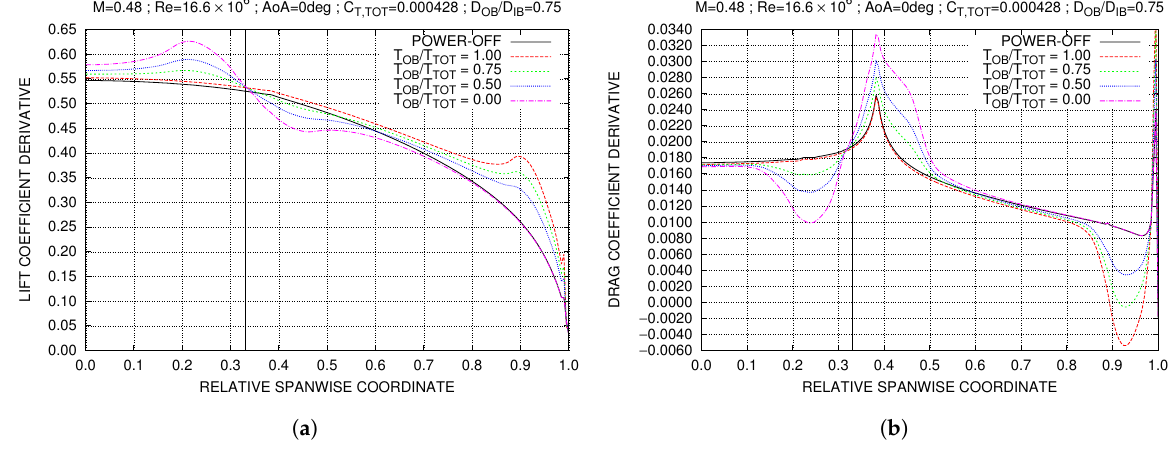
Figure 14. Wing spanwise loading with IB and OB propellers in cruise conditions at constant total thrust: ( a ) lift coefficient derivative; ( b ) drag coefficient derivative.